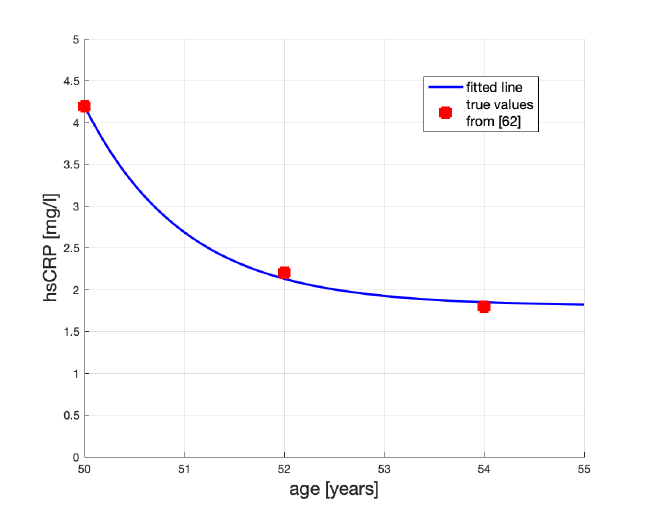
Figure 6. The decreasing effect of statins treatment on